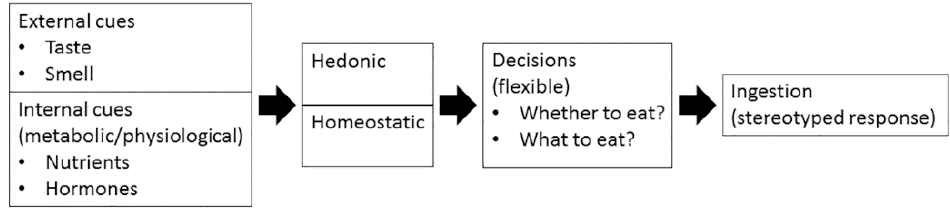
Figure 1. Decision making and feeding behavior.